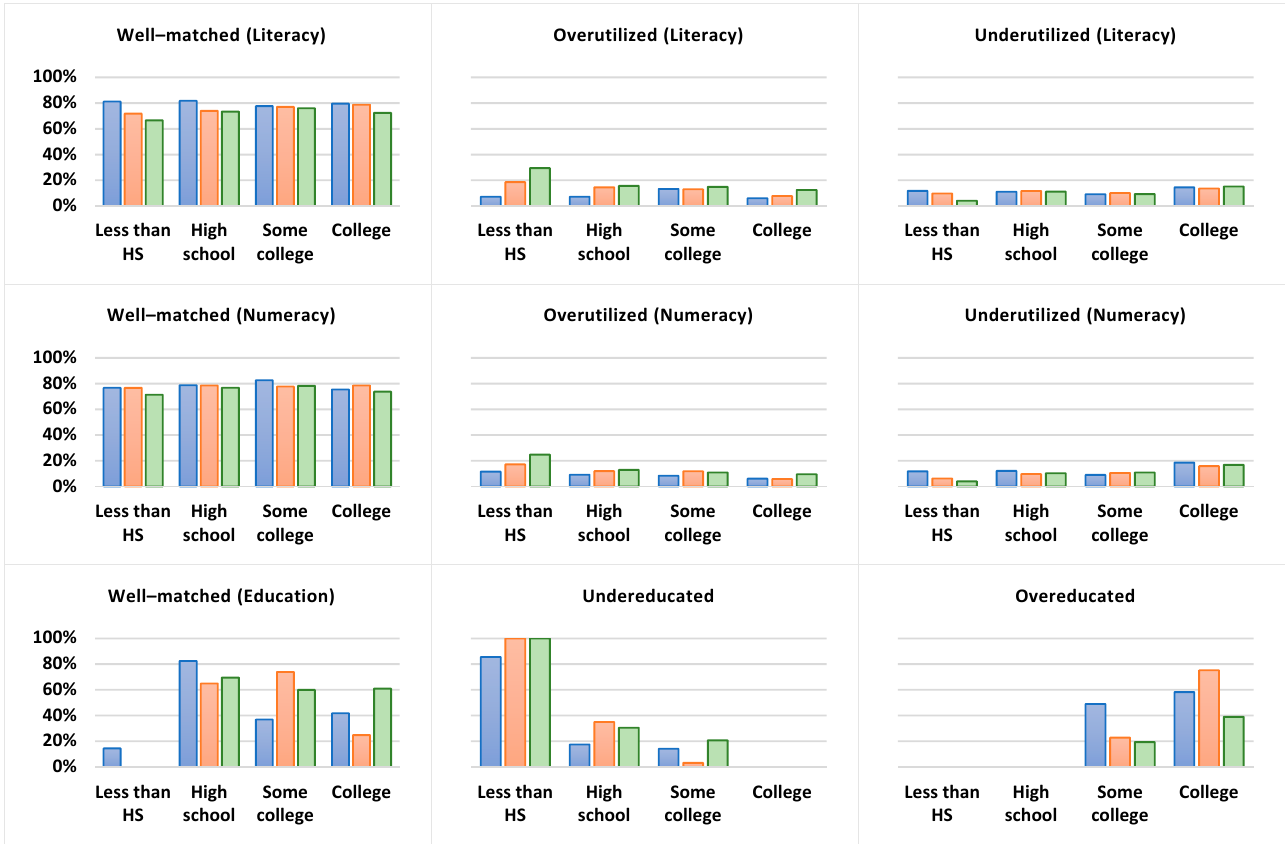
Figure 5. Skill and educational mismatch by educational attainment. Note: blue—IALS (1994); orange—ALL (2003); green—PIAAC (2012).